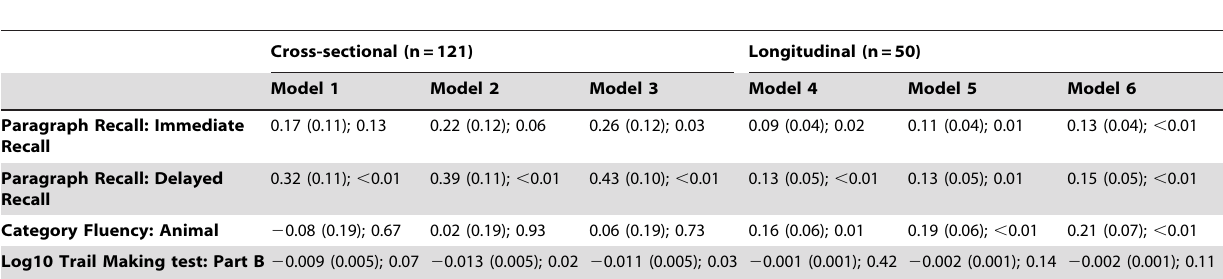
Table 2. Relationships between baseline CSF BDNF concentration with cross-sectional and longitudinal cognitive